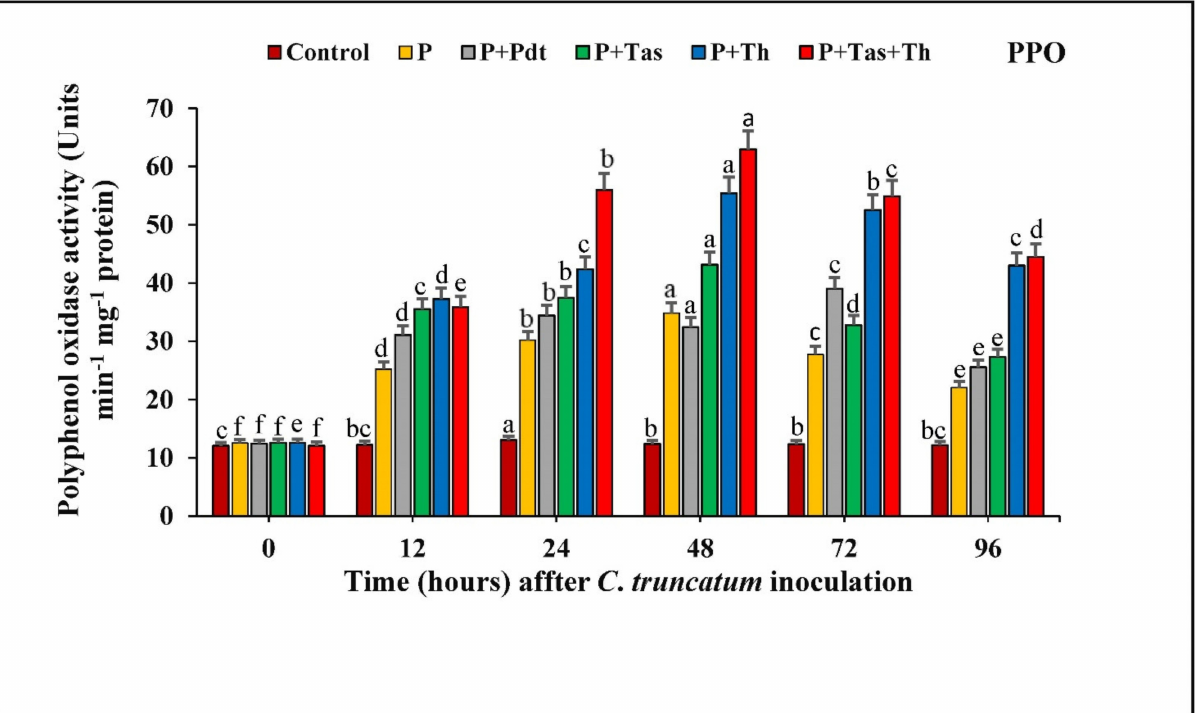
Figure 11. The effect of bioagents (Pdt = P. dendritiformis, Tas = T. asperellum, Th = T. harzianum, and Tas+Th = T. asperellum + T. harzianum ) on the accumulation of the defence enzyme (PPO) either individually or in the combination of treatment in chilli seeds under a challenged condition and C. truncatum -infected samples. Each value is expressed as the mean of triplicates, and the bars sharing the same alphabetical letters are not significantly different ( p ≤ 0.05) using Duncan’s multiple range test. The vertical bar designates the standard